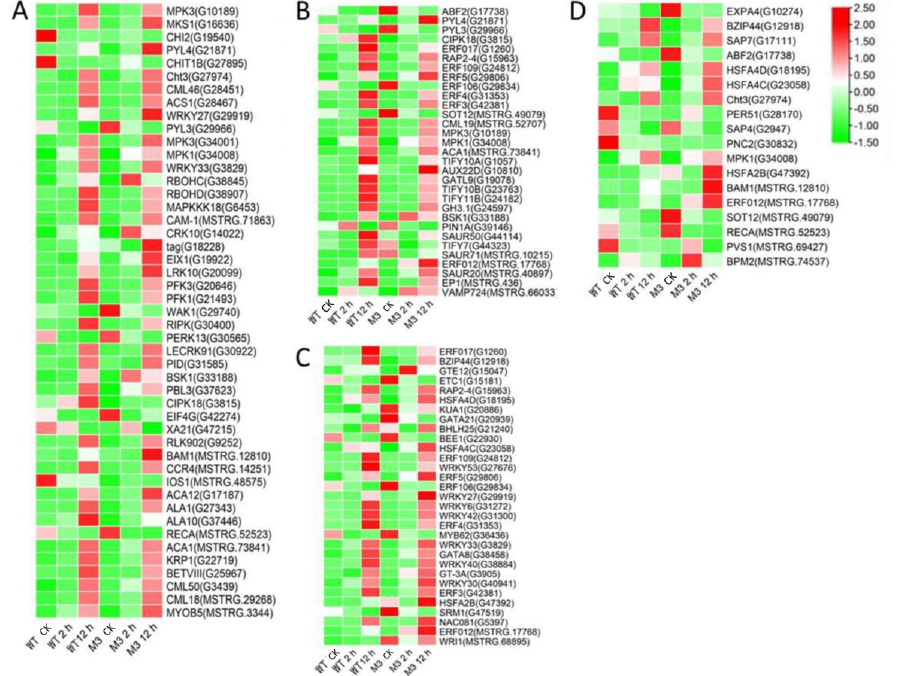
Figure 9. Heatmap of DEGs expressed faster in M3 plants than in WT plants. ( A ) Protein kinase and Ca 2+ signal-related genes, ( B ) hormone-related genes, ( C ) transcription factors, and ( D ) stress-related genes were identified. The sample and treatments are displayed at the bottom of each column. Relative expression levels are shown by a colored gradient, from low (green) to high (red). Scale bars represent the log 2 transformations of the RPKM values.